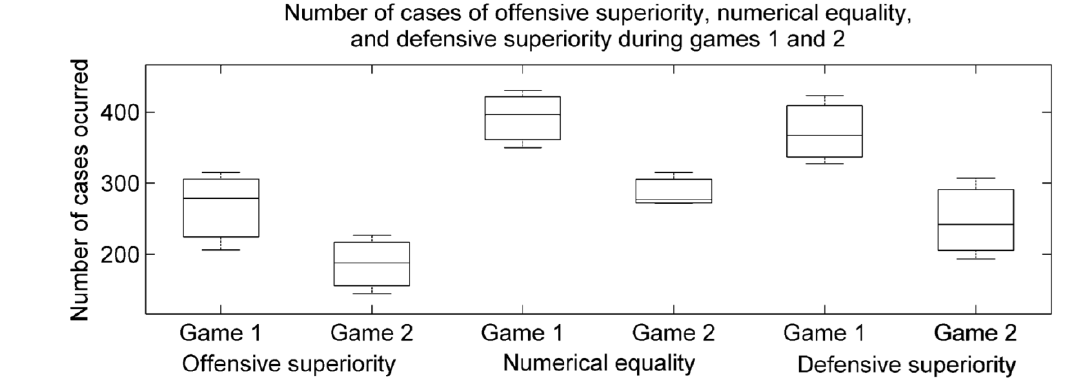
Figure 4. Box plot of the number of cases of offensive superiority, numerical equality, and defensive superiority during Games 1 and 2.